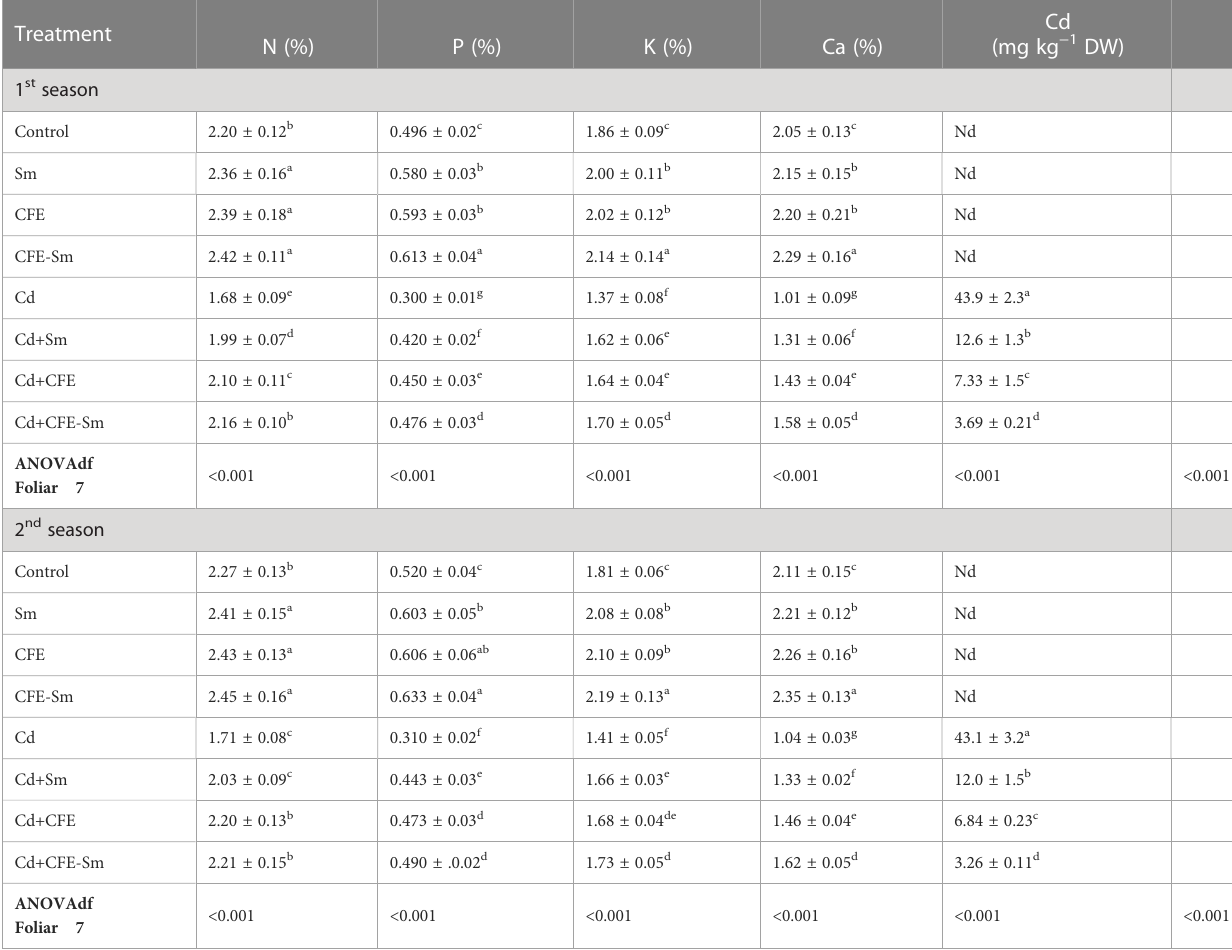
TABLE 3 N, Nitrogen; P, phosphorus; P, potassium; Ca, calcium; and Cd, cadmium; response to foliar application of Sm, silymarin; CFE, clove fruit extract; or CFE-Sm, silymarin-enriched clove fruit extract; under Cd stress.